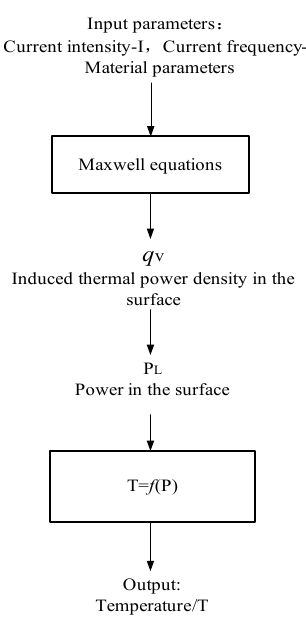
Figure 2. Schematic flow of the variables in temperature evolution.